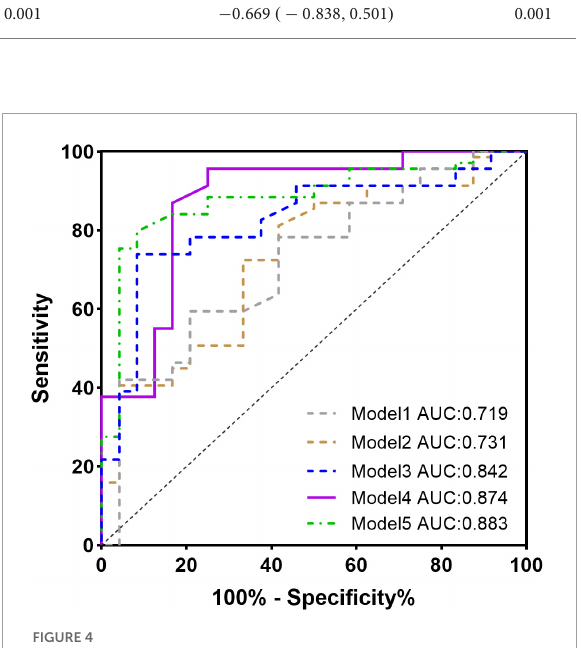
FIGURE4 ROC curve for the multivariate logistic regression model predicting the presence of late gadolinium enhancement